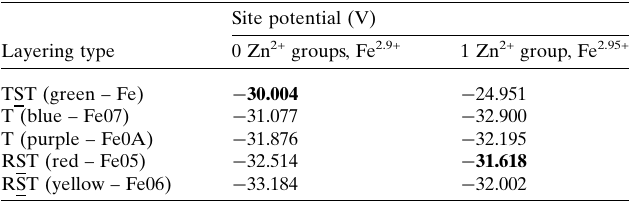
The energy increase compared with the lowest-energy structure for placing zinc atoms in the given number of RST (black), TST (blue) and T (red) groups of symmetry-related tetrahedra for the (34) 3 hexaferrite. The low-energy values are shown in the inset. Lines are a guide for the eye, with the dashed black line indicating a point representing two RST groups with the additional constraint that the two tetrahedral sites are located within the same R ST layer.